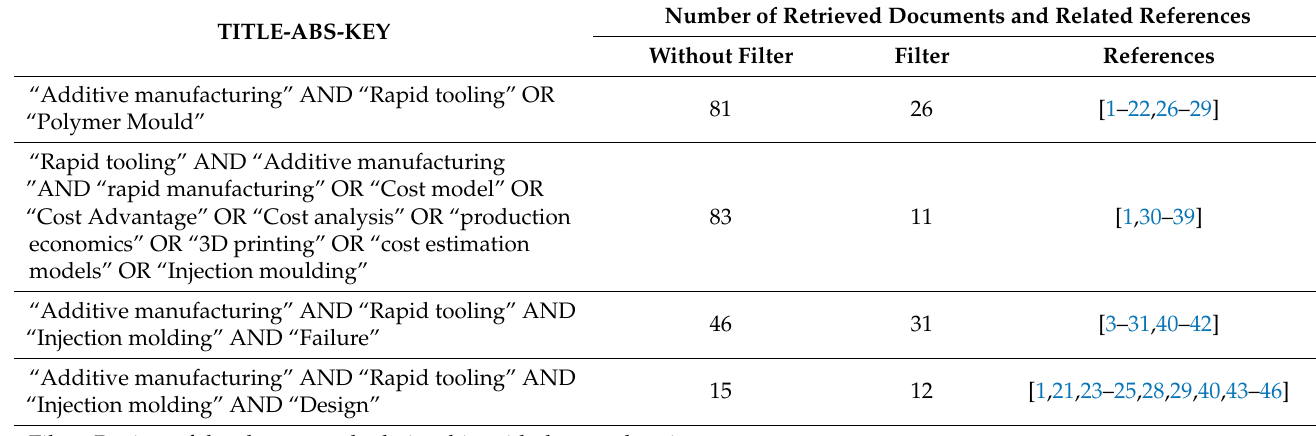
Table 1. Search results obtained with each